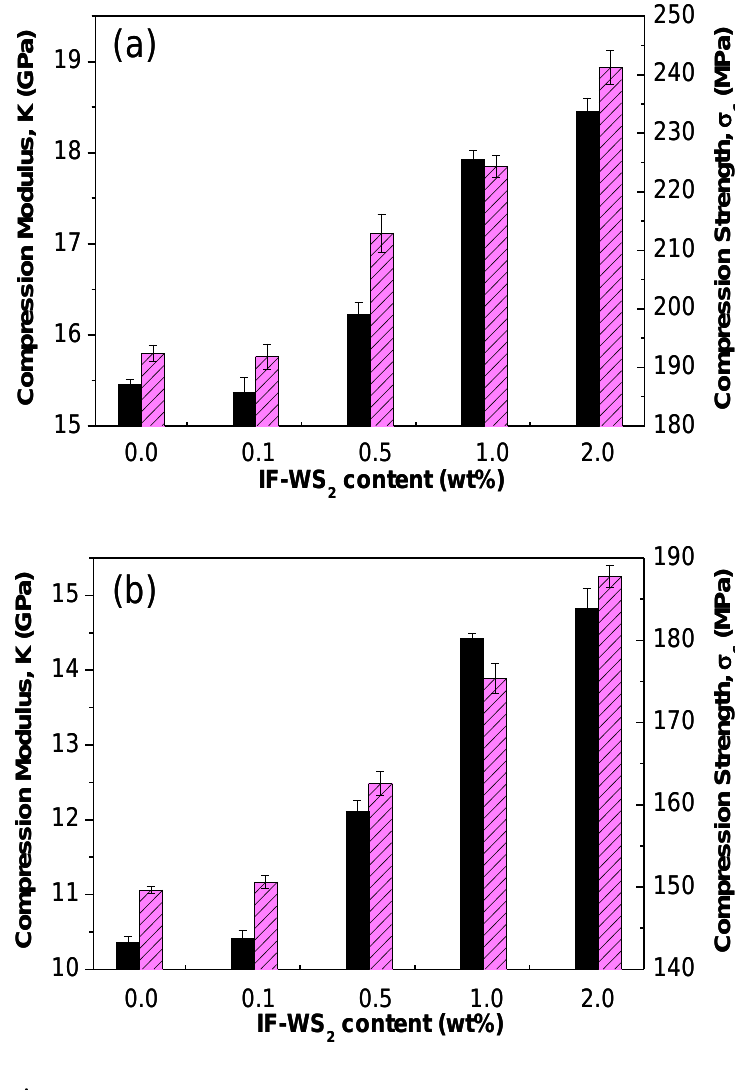
Figure 3. Effect of the IF-WS nanoparticles on the compression modulus K (solid bars) 2 and strength σ (dashed bars) of PPS/CF laminates. ( a ) 25 °C; and ( b ) 120 c